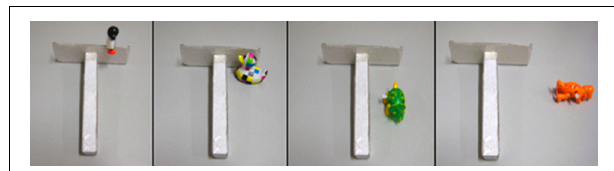
FIGURE 1 | Rake and toys in the different conditions of testing from C1 to C4. (C5 is not shown: the toy is placed too far to be reached and the rake is handed directly to the